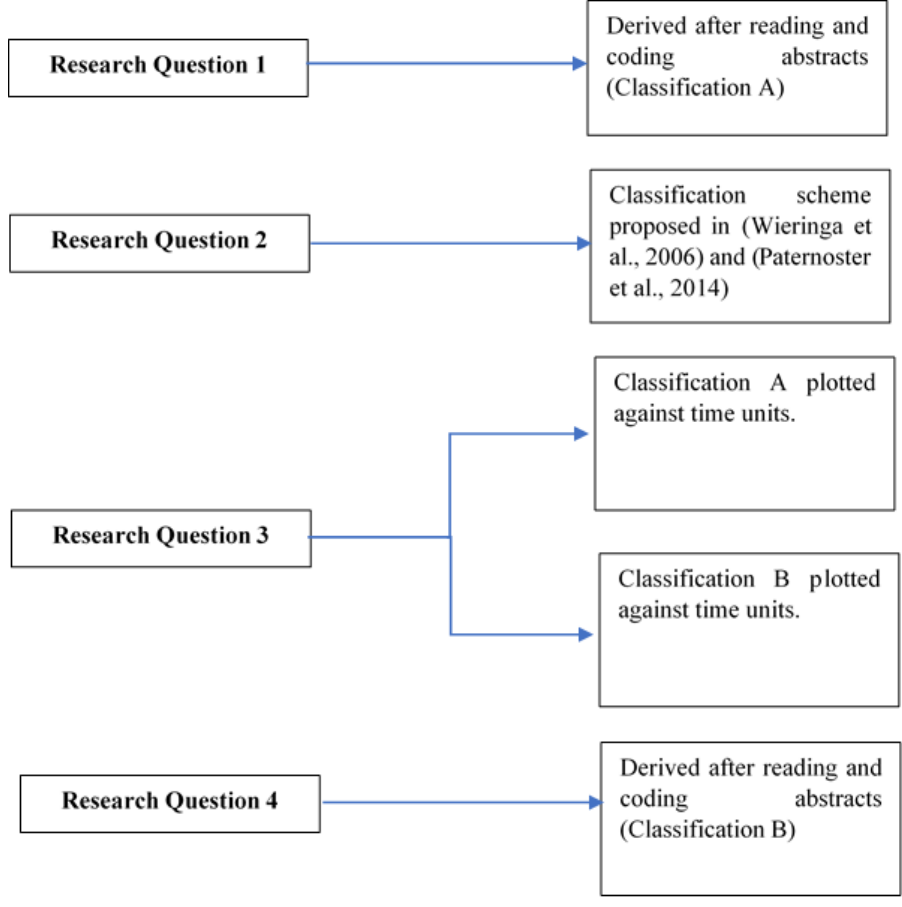
Figure 1. Mapping between research questions and classification schemes.